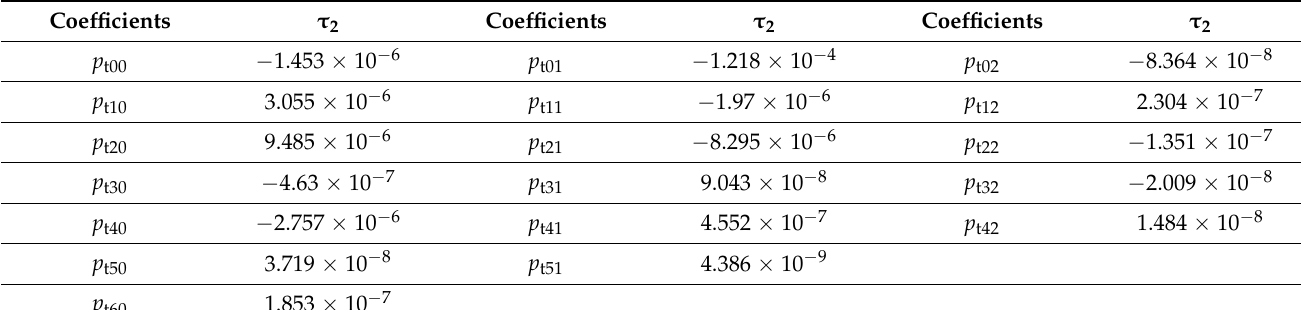
Table 4. Coefficients of approximating polynomials of the magnetic